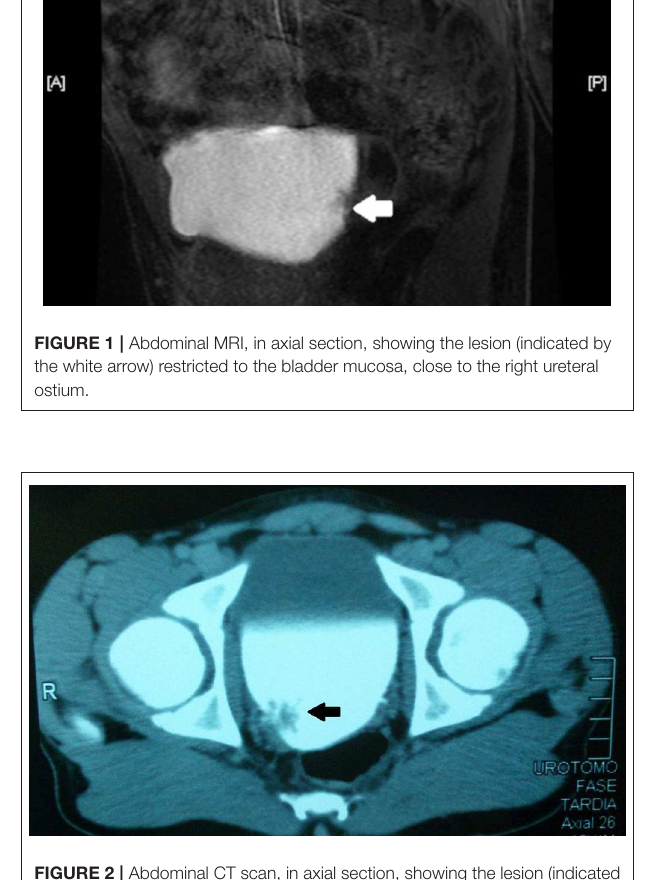
FIGURE 2 | Abdominal CT scan, in axial section, showing the lesion (indicated by the black arrow) in the right posterolateral bladder